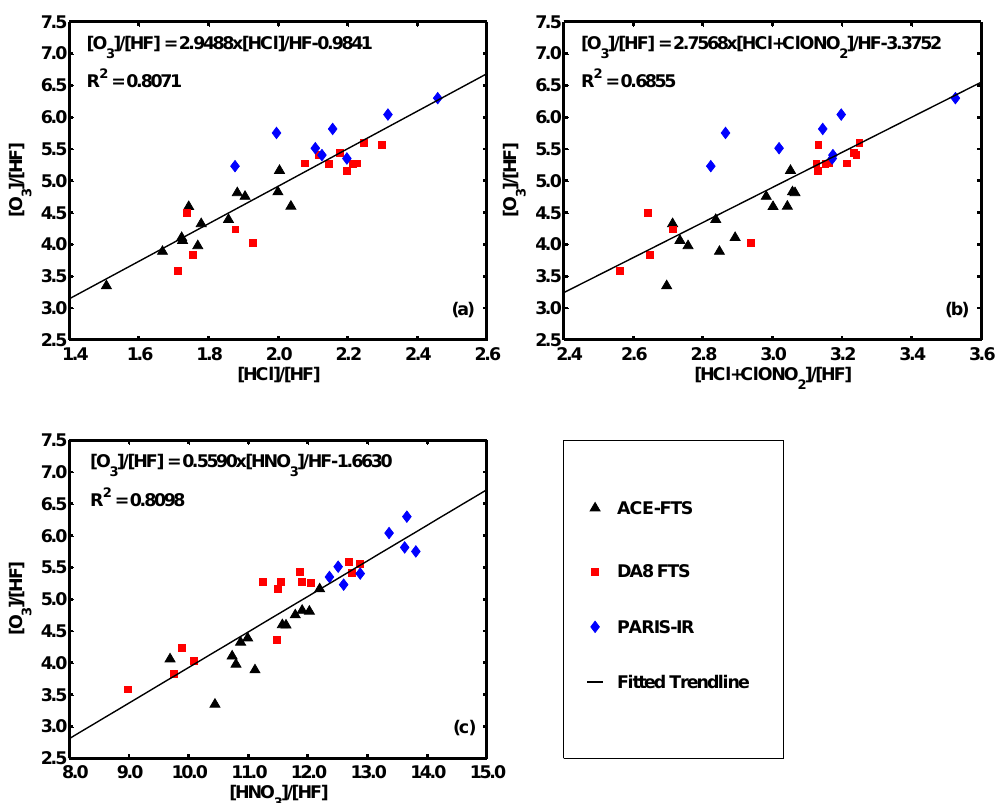
Fig. 8. Scatter plot of (a) partial column ratio of [HCl]/[HF] vs. [O 3 ]/[HF] from ACE-FTS (black triangles) along with total column ratios of [HCl]/[HF] vs. [O 3 ]/[HF] from PARIS-IR (blue diamonds) and the DA8 FTS (red squares). (b) Same as (a), but for [HCl+ClONO 2 ]/[HF] vs. [O 3 ]/[HF]. (c) Same as (a), but for [HNO 3 ]/[HF]. The altitude ranges of the partial column density ratios of [HCl]/[HF], [ClONO 2 ]/[HF], [HNO 3 ]/[HF], and [O 3 ]/[HF] from ACE-FTS are 13.5–44.5km, 14.5–30.5km, 13.5–31.5km and 13.5–44.5km, respectively. The altitude ranges of the total column density ratios from the DA8 FTS and PARIS-IR are surface – 100km. In all figures, the solid line indicates the fitted correlation between x and y domains. The correlation function and R 2 are given on the